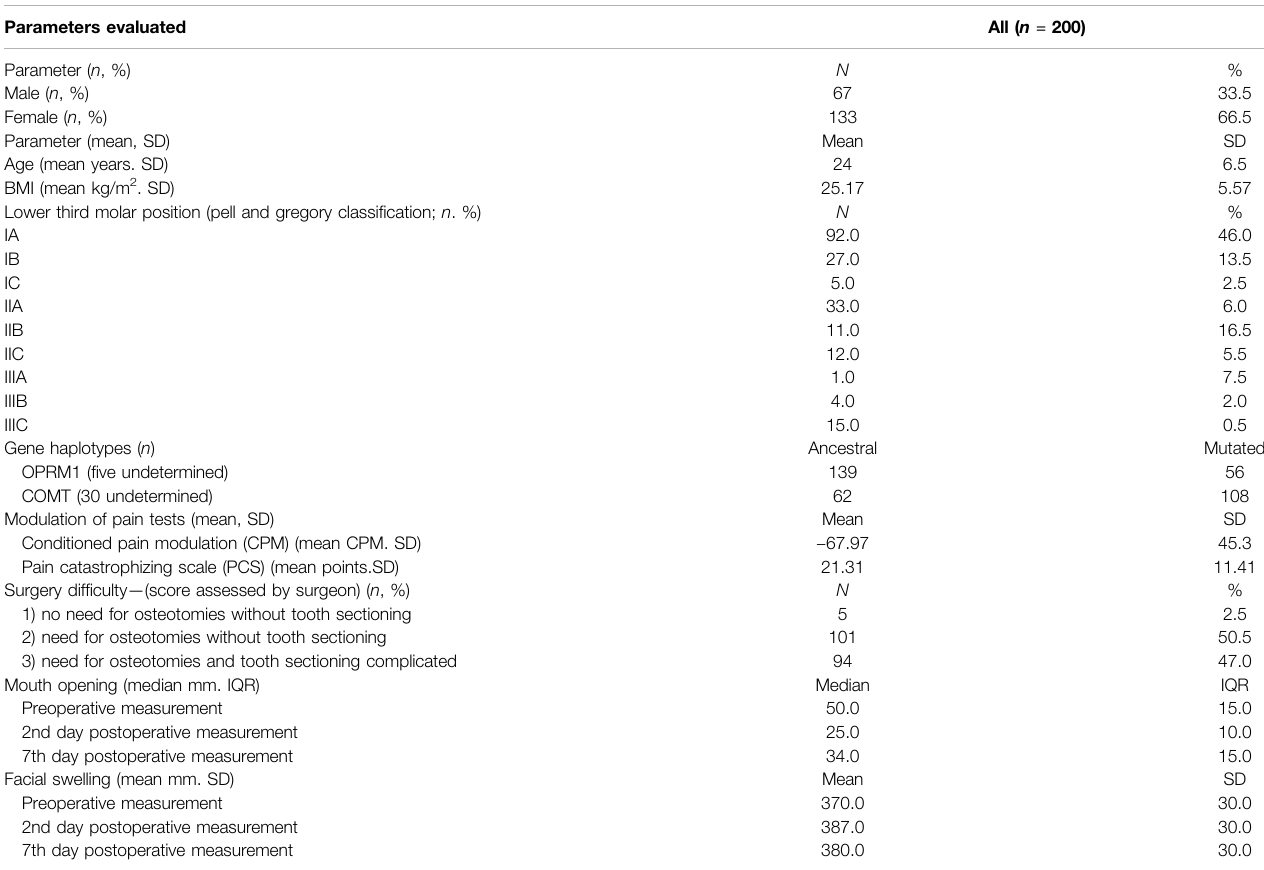
TABLE 2 | Evaluated study parameters. Parameters